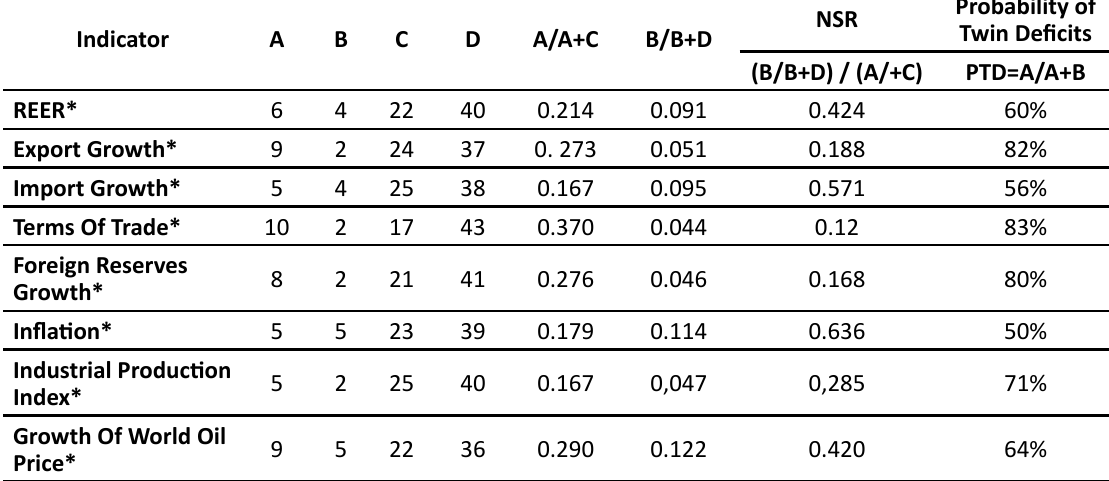
Table 4: Signal Total in Indonesia